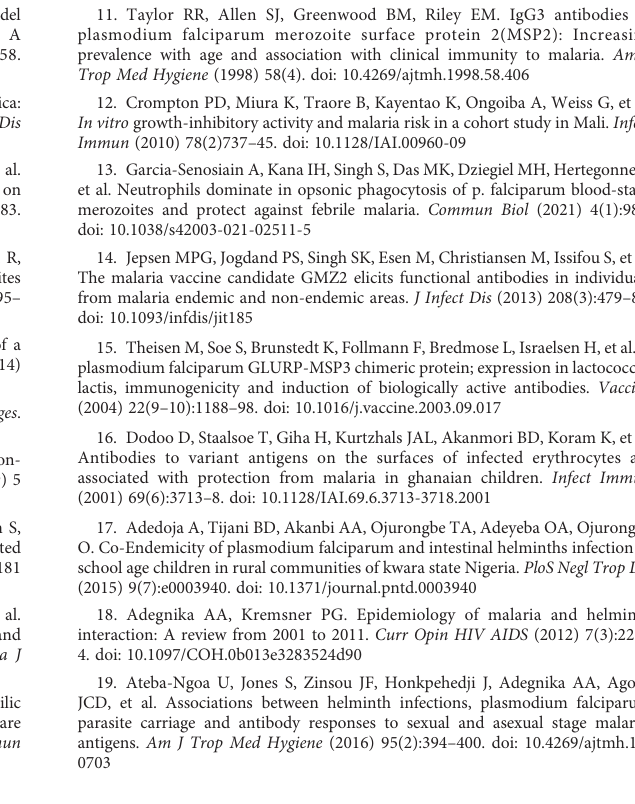
SUPPLEMENTARY FIGURE 1 Helminth infections have no effect on the levels of immunoglobulin G to GMZ2. The data is presented as a box plot with interquartile range and whiskers. Helminths consist of H. nana , Hookworm and S. haematobium grouped together, Pf, Plasmodium falciparum infection, Pf/Helminth, P. falciparum -helminth comorbidity and No infection, no parasitic infection. Kruskal-Wallis analysis of rank variance was used to analyze the data followed by Dunn correction for multiple comparisons with a signi fi cance level set at p <